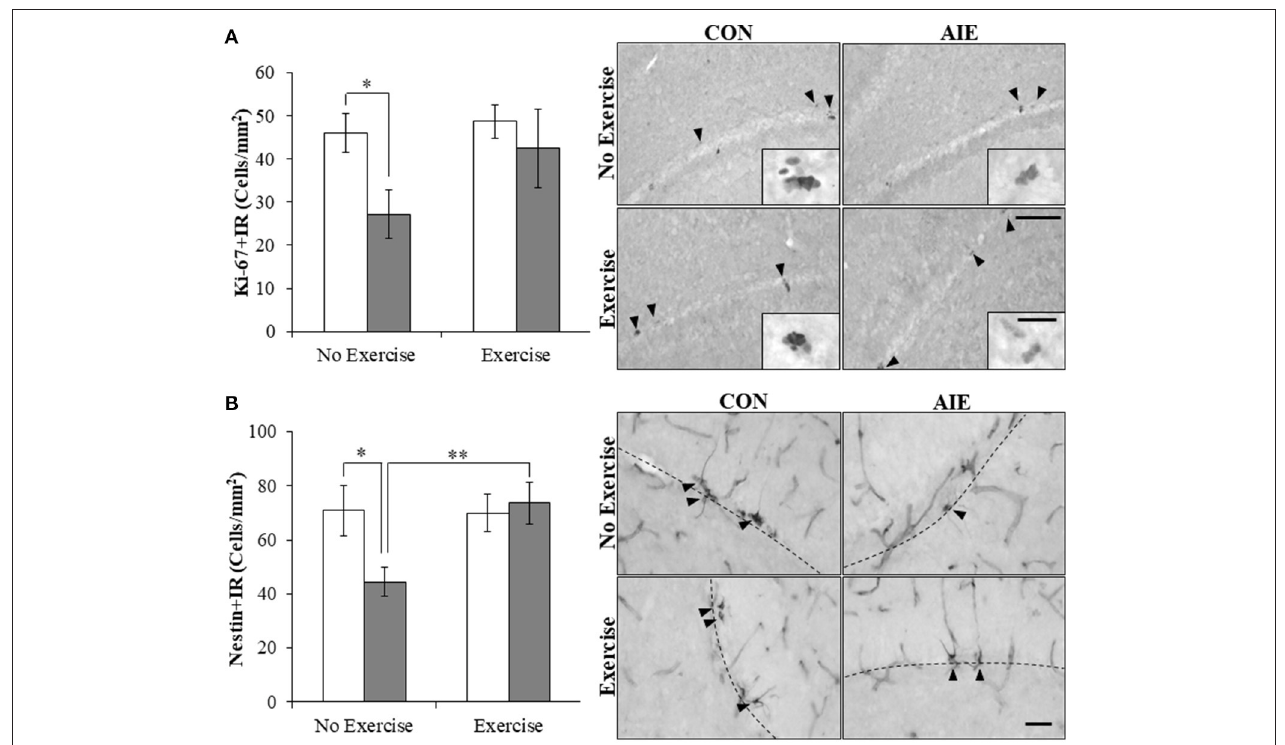
FIGURE 3 | Voluntary wheel running prevented the adolescent intermittent ethanol (AIE)-induced loss of neuroprogenitor marker expression in the adult hippocampal dentate gyrus. (A) Modified unbiased stereological assessment revealed a 41% ( ± 12%) reduction of Ki-67 + IR cells in the adult (P80) hippocampal dentate gyrus of AIE-treated animals, relative to CONs. Running wheel exposure from P24 to P80 blunted the AIE-induced loss of Ki-67 + IR cells, relative to the AIE animals. Representative photomicrographs of Ki-67 + IR cells in the adult hippocampal dentate gyrus from CON- and AIE-treated animals across exercise conditions. Scale bar = 100 µ m (Insert: 10 µ m). (B) Modified unbiased stereological assessment revealed a 37% ( ± 8%) reduction of nestin + IR cells in the adult hippocampal dentate gyrus of AIE-treated animals, relative to CONs. Subjects in the AIE treatment group that were exposed to running wheels from P24 to P80 did not evidence the observed loss of nestin + IR cells, relative to the AIE animals. Representative photomicrographs of nestin + IR cells in the adult hippocampal dentate gyrus from CON- and AIE-treated animals across exercise conditions. Scale bar = 50 µ m. Dashed lines indicate outline of the granule cell layer of the hippocampal dentate gyrus. Data are presented as mean ± SEM. * p < 0.05, ** p <